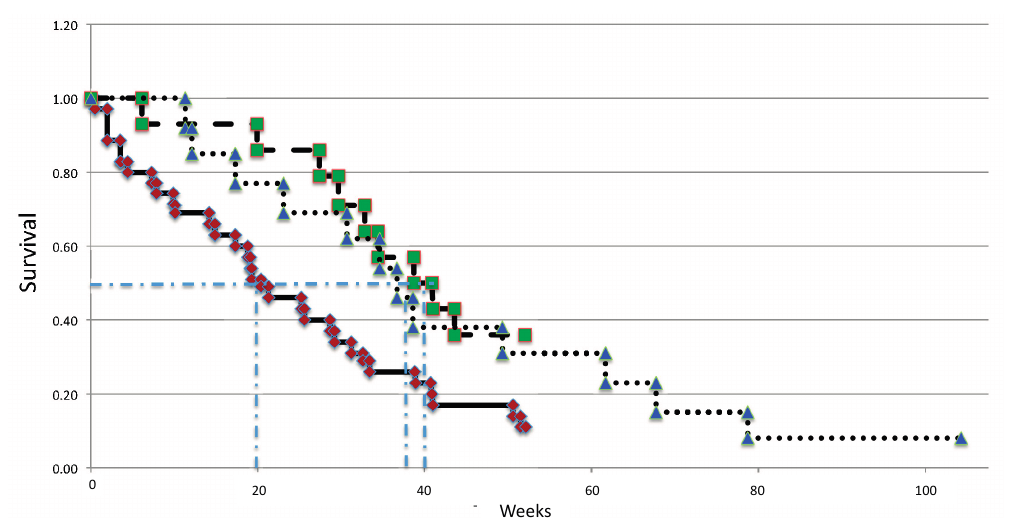
Figure 2. Kaplan–Meier curves describing the survival of patients from the phase 1/2 trial (green boxes), the phase 2 trial (blue triangles) and an age and disease stage matched historic control group receiving the best available standard care (red diamonds).